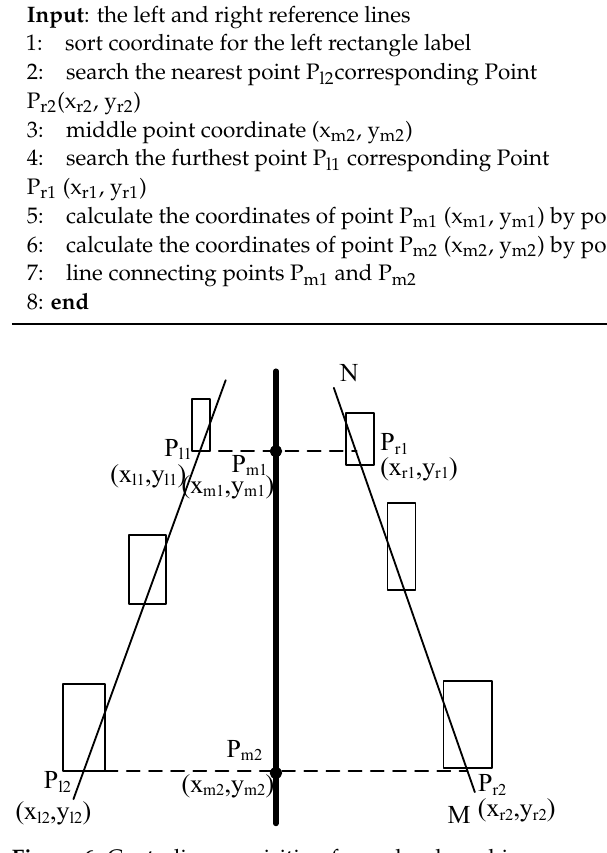
Figure 6. Centerline acquisition for orchard machinery. Algorithm 3 Obtain the centerline